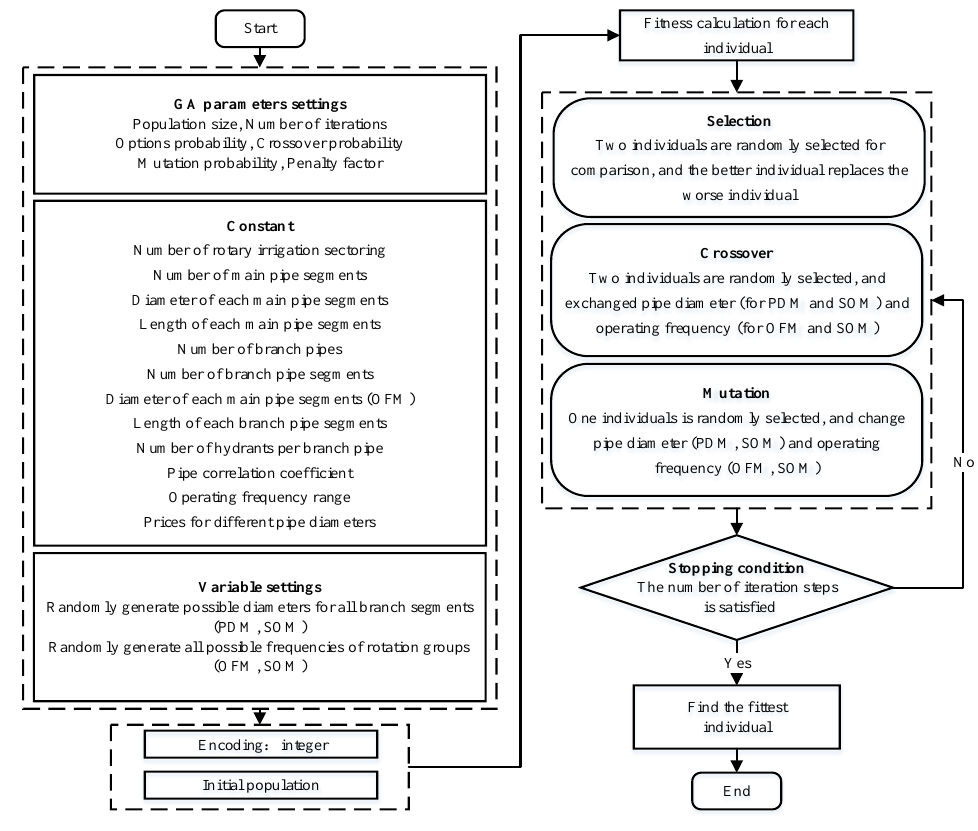
Figure 4. The basic calculation flow chart of the GA.